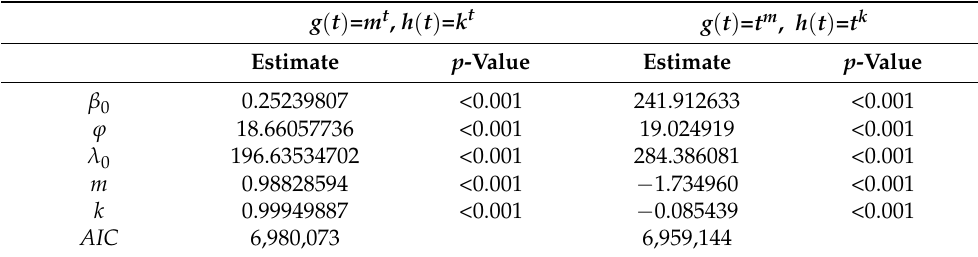
Table 4. Time-varying TR and RDR estimated by Equation (17).